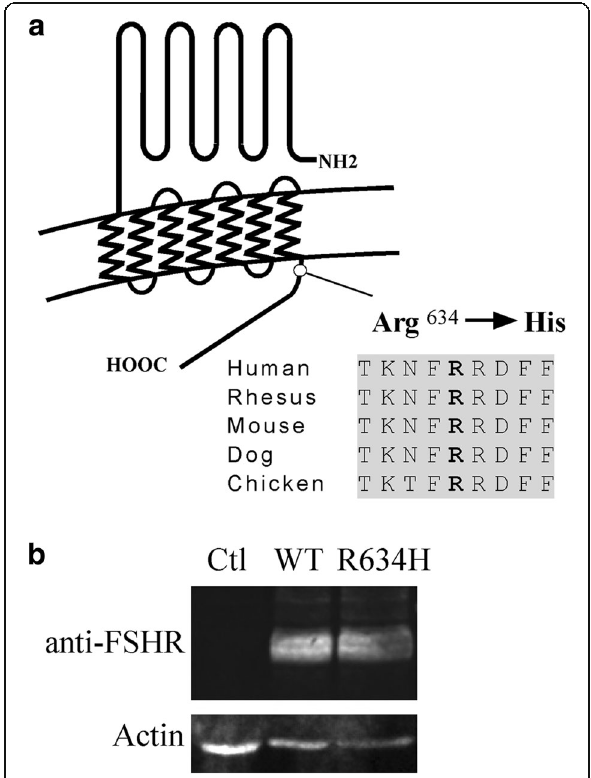
Fig. 2 New FSHR mutation located in the beginning of the cytoplasmic tail and expression level of wild-type and mutated receptor after transfection. a Schematic representation of follicle-stimulating hormone receptor (FSHR) with the location of the R634H mutation in the beginning of the cytoplasmic tail and sequence alignment of amino-acid from chicken to human. b The expression level of wild-type (WT) and R634H in transfected COS-7 cells, is shown by western blot using specific